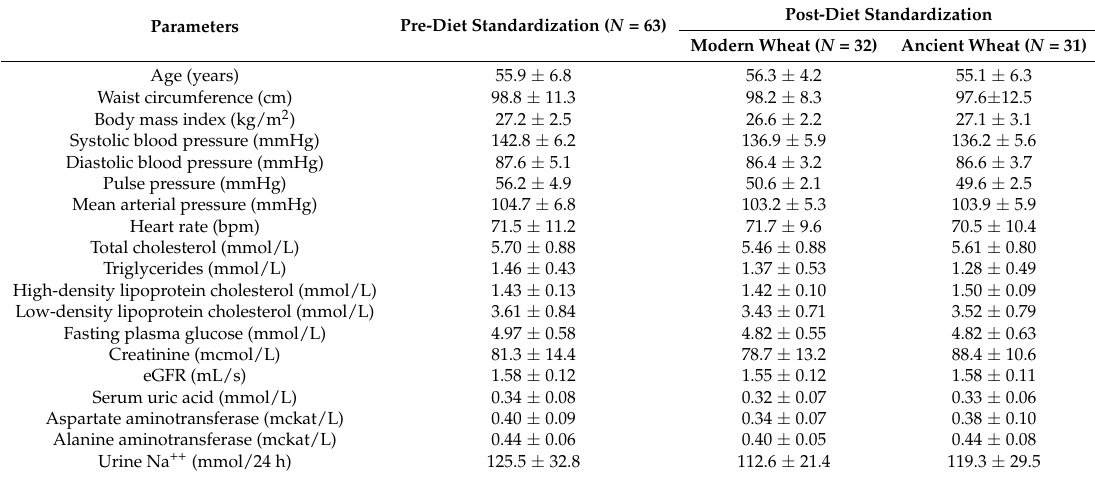
Table 3. Pre-diet standardization and post-run-in parameters by assigned sequence group (modern wheat foodstuffs first or ancient wheat foodstuffs first), expressed as mean ± standard